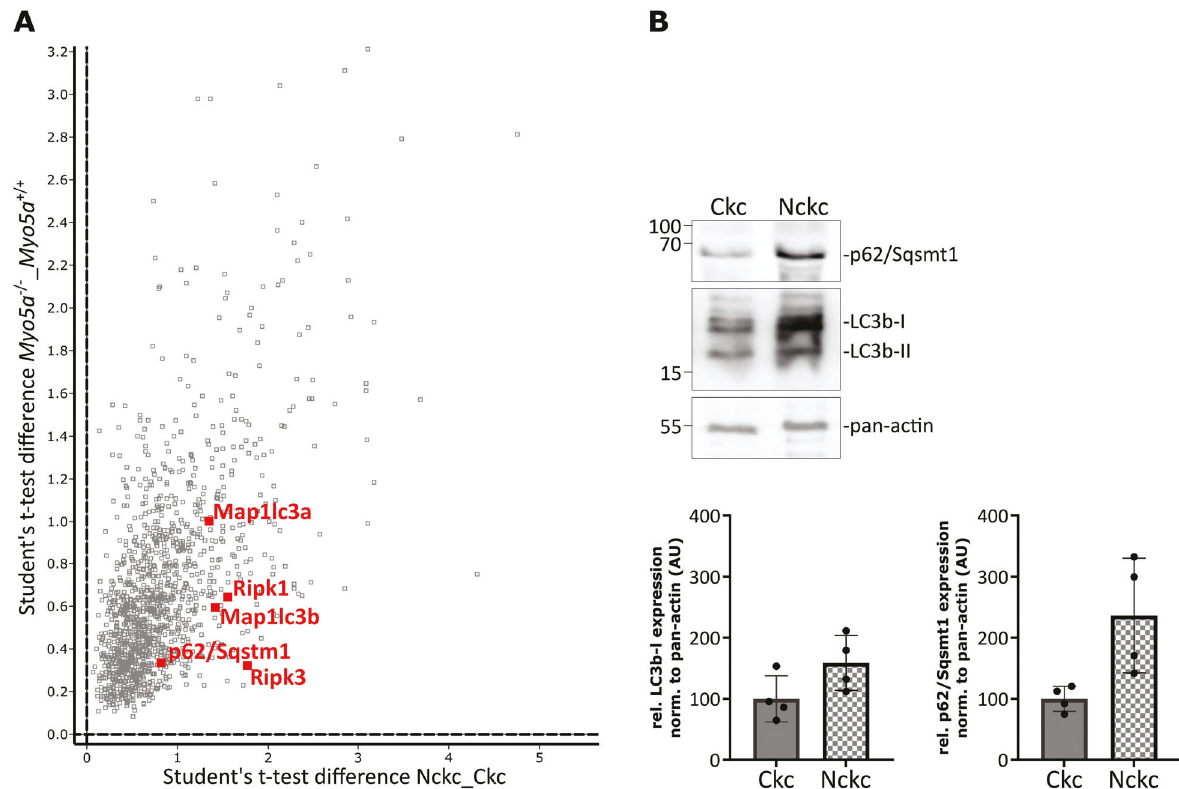
Fig. 4 Loss of cilia induces upregulation of the p62/Ripk1 module. A Details from the scatter blot (total plot in Suppl. Fig. 4E) highlighting proteins connecting the autophagosome and the necrosome. B Immunoblot analyses of DMSO treated Nckc versus Ckc for LC3 (~17 kDa)